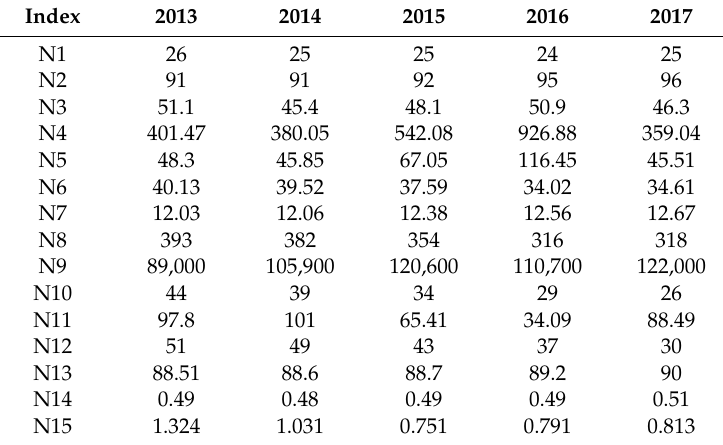
Table 4. The indicators of the water resource value assessment system.